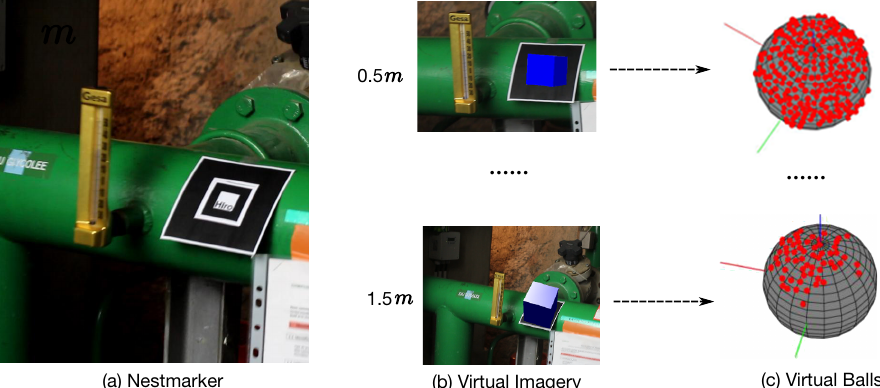
Figure 3. Main idea of WatchPose. ( a ) The Nestmarker is placed close to the target object. ( b ) A virtual imagery is drawn for checking the correctness of marker tracking (the blue box) from different camera distances. ( c ) For each camera distance interval, a virtual ball is drawn and automatically switched for visualizing the captured viewpoints (the red points) and navigating the uncovered